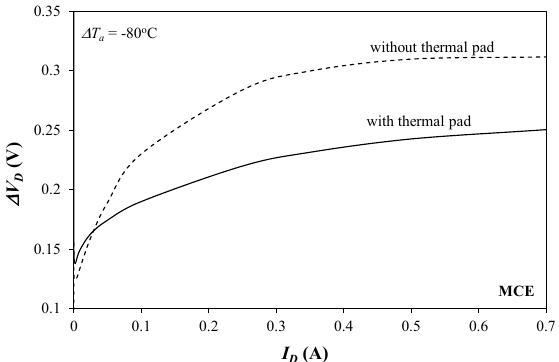
Figure 5. Measured MCE diode forward voltage change Δ V D in response to the cold plate variation by 80 °C in function of the diode forward current.